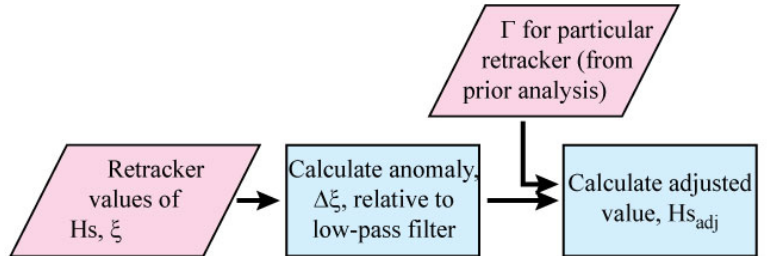
Figure 4. Flowchart describing the implementation. In this work, Γ for MLE-4 is − 4.26 (with other values for other retrackers); alternatively, this could be a lookup table as a function of Hs, as chosen by Tran et al. [13] and discussed in the Appendix of this paper.